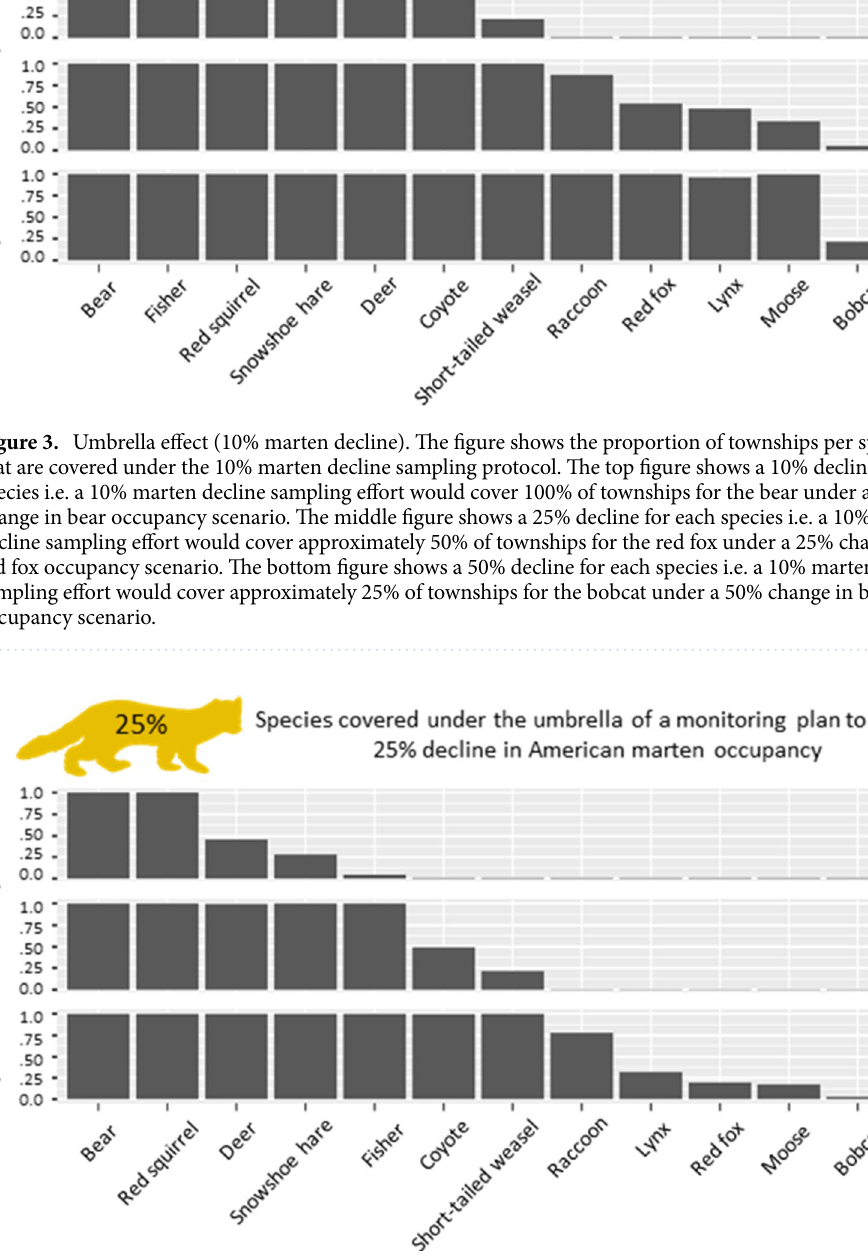
Figure 4. Umbrella effect (25% marten decline). The figure shows the proportion of townships per species that are covered under the 25% marten decline sampling protocol: top are covered at a 10% decline, middle at a 25% decline, and bottom at a 50%